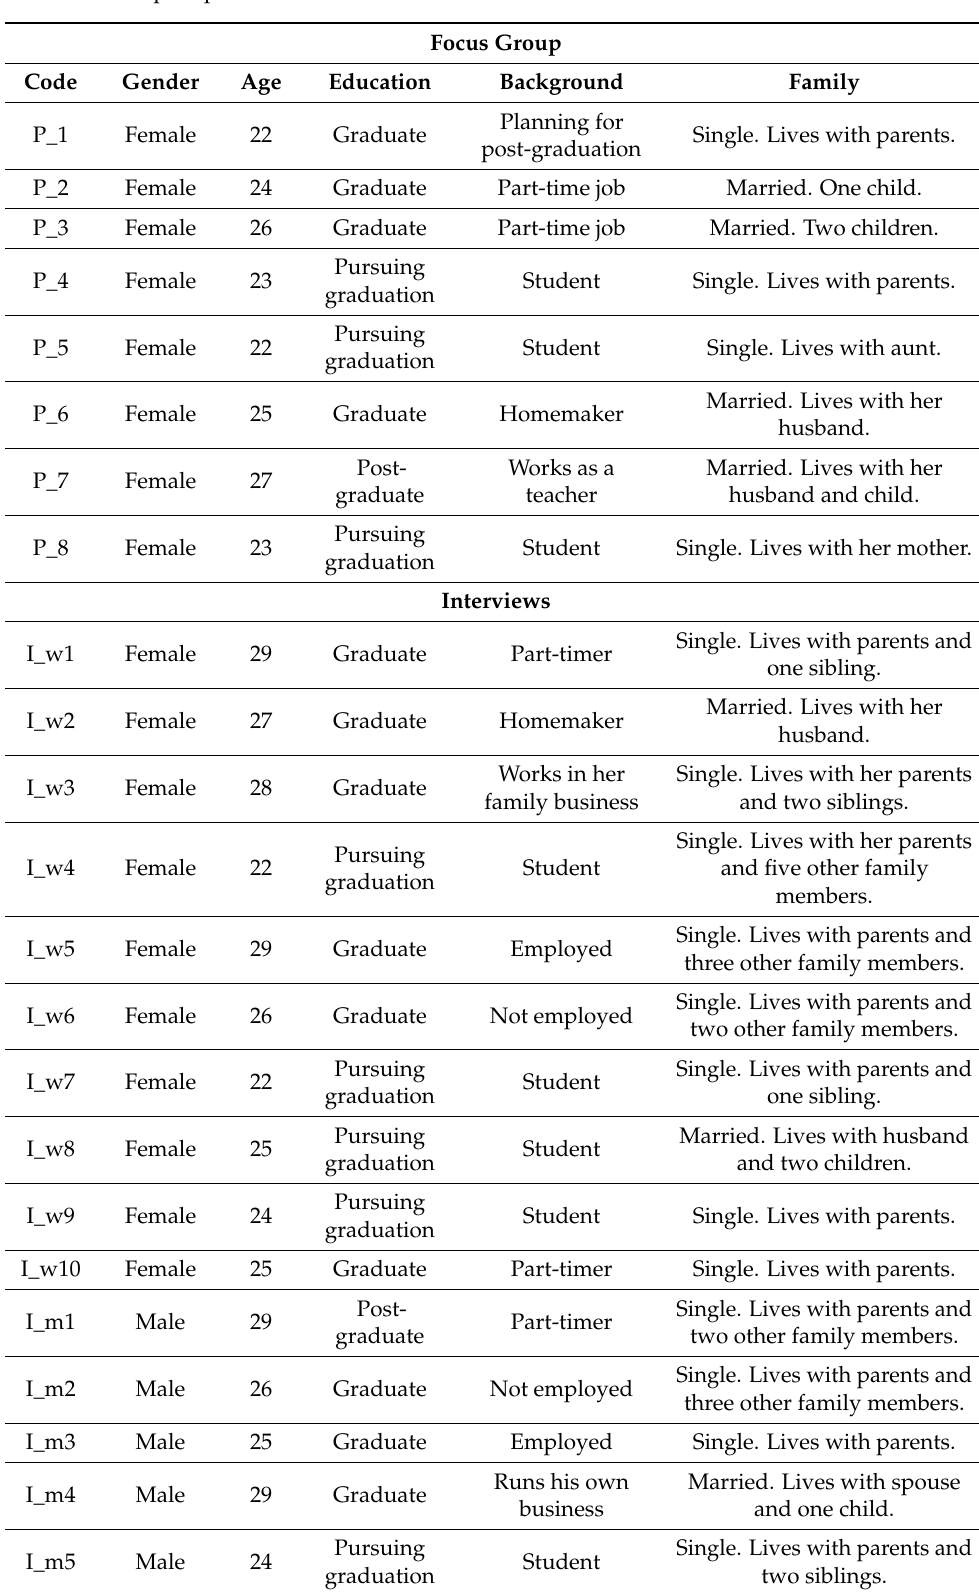
Table 1. Participant